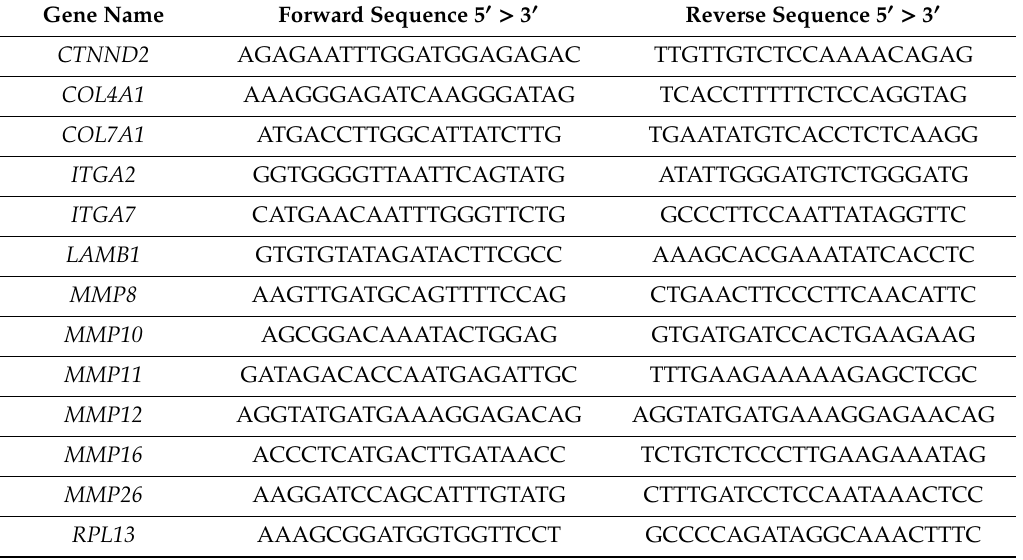
Table 2. Primers sequences of SYBR ® Green